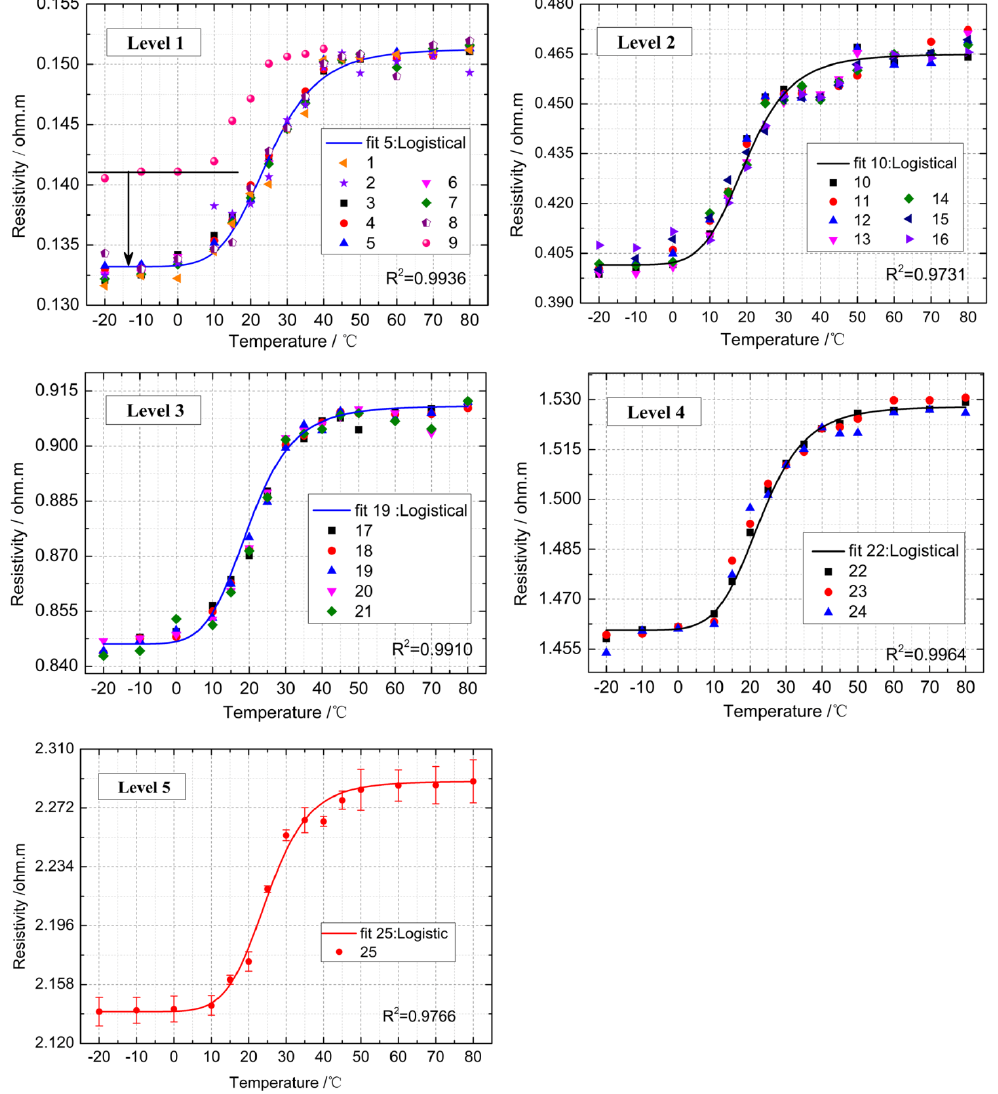
Figure 7. Variations of block resistivity ρ with temperature 𝑇 in side A for 10 Ah cell with SOC of 5%. All data in the graphs are the average of ten independent measurements. The dotted lines are the logistical fit to the representative blocks discussed in Section